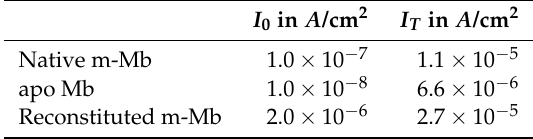
Figure 2. Current density curves of experiment [26], reconstructed using (73). Start and end points of curves visually extracted from original figure. For activation energy, the gap between HOMO and HOMO-1 energies have been used, in accordance with (68). Table 1. Parameter values reproducing the Myoglobin measurement results of